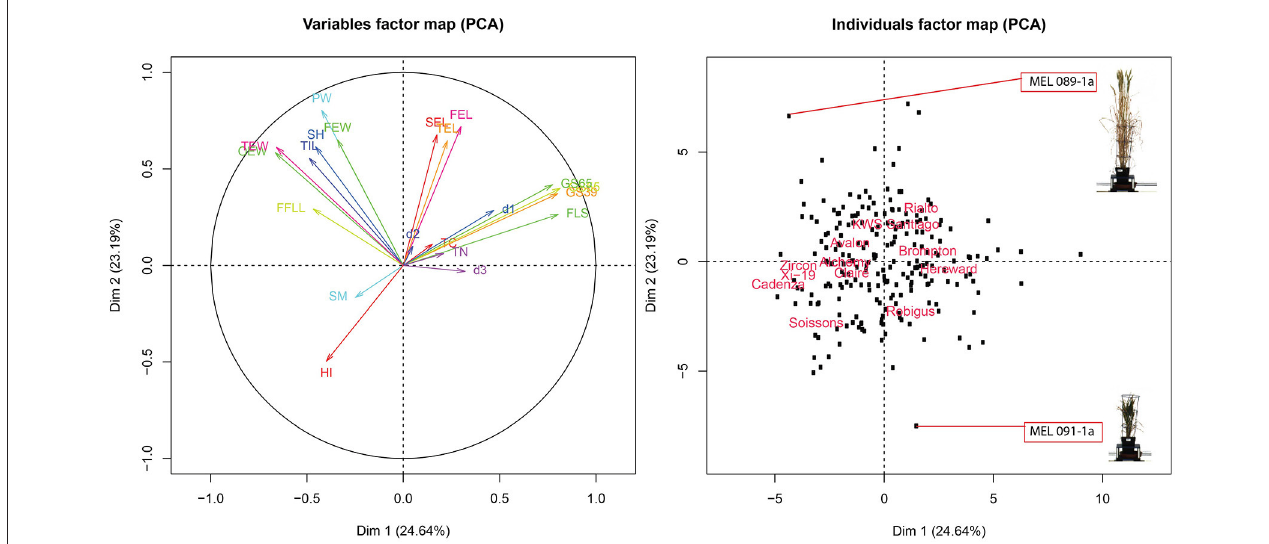
FIGURE 6 | (Left panel) PCA score biplot for 18 different traits. (Right panel) Biplot corresponding to 8 MAGIC parent, 4 elite lines and 208 RILs. MAGIC parents are labeled only to facilitate